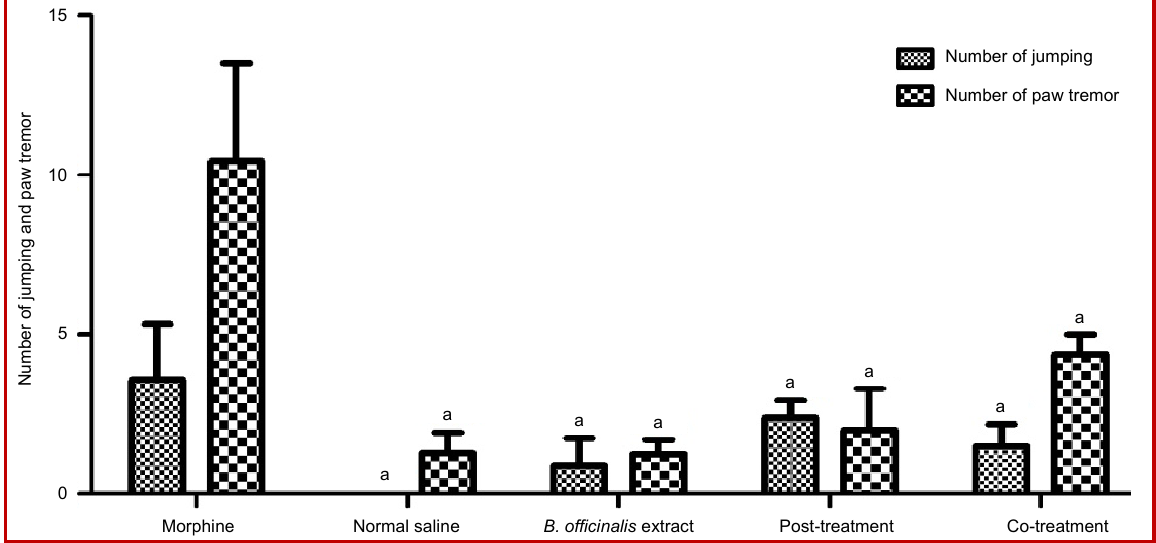
Figure 1: The effect of Borago officinalis extract injection, as post-treatment and co-treatment, on the frequency of naloxone-induced jumping and paw tremor in morphine-dependent mice; a